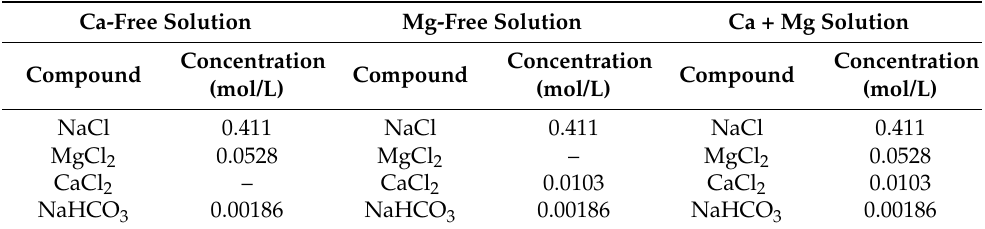
Table 3. Chemical composition of the used artificial seawater.